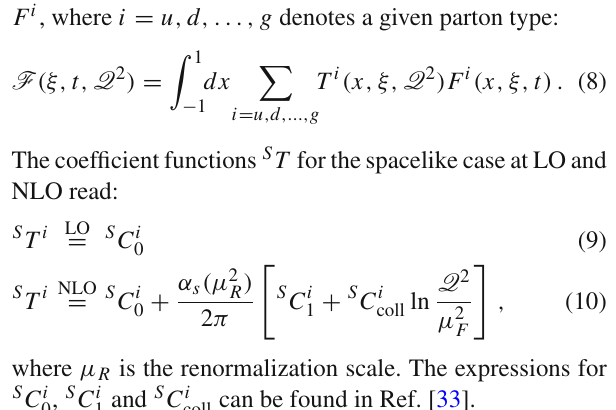
t = − 0 . 3 GeV 2 . For comparison, we also present a model predictionbasedontheGoloskokov-Kroll(GK)parametriza- tion of GPDs [34–36], obtained with LO (dashed line) and NLO (solid line) coefficient functions. All those quantities are used to perform predictions for TCS CFF T H , which are presentedinFig.2.ThederivativesinEqs.(15,16)arenumer- ically evaluated using the GSL library [37]. The smoothness of individual CFF replicas is ensured by a careful selection of the artificial neural network size and by the usage of reg- ularization methods (for details see Ref. [16]). The bigger uncertainty of the NLO result (dashed blue band) as compared to the LO one (shaded red band),